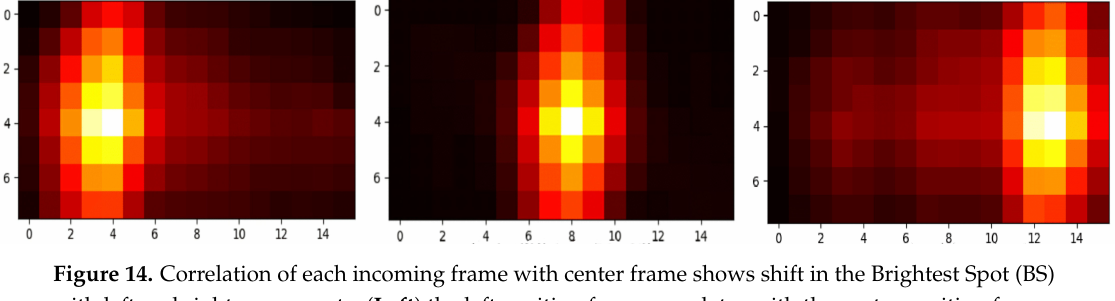
Figure 14. Correlation of each incoming frame with center frame shows shift in the Brightest Spot (BS) with left and right movements. ( Left ) the left position frame correlates with the center position frame: BS(4, 4), ( Center ) the center position frame correlates with itself: BS(8, 4); ( Right ) the right position frame correlates with the center frame: BS(13, 4).